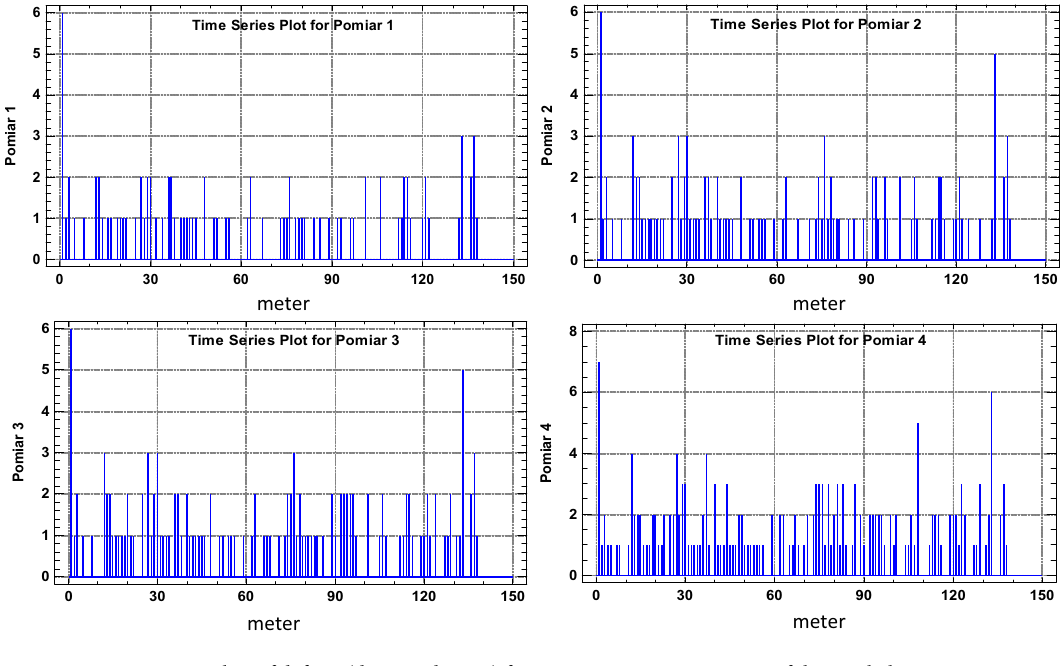
Figure 12. Number of defects (damage density) for consecutive 1-m segments of the 7–8 belt Sect. 138 m in length, in consecutive scans 5,42 [Statgraphics Centurion Version 18.1.06 64-bit version (academic license of Wrocław University of Science and Technology), https:// www. statg raphi cs. com/].